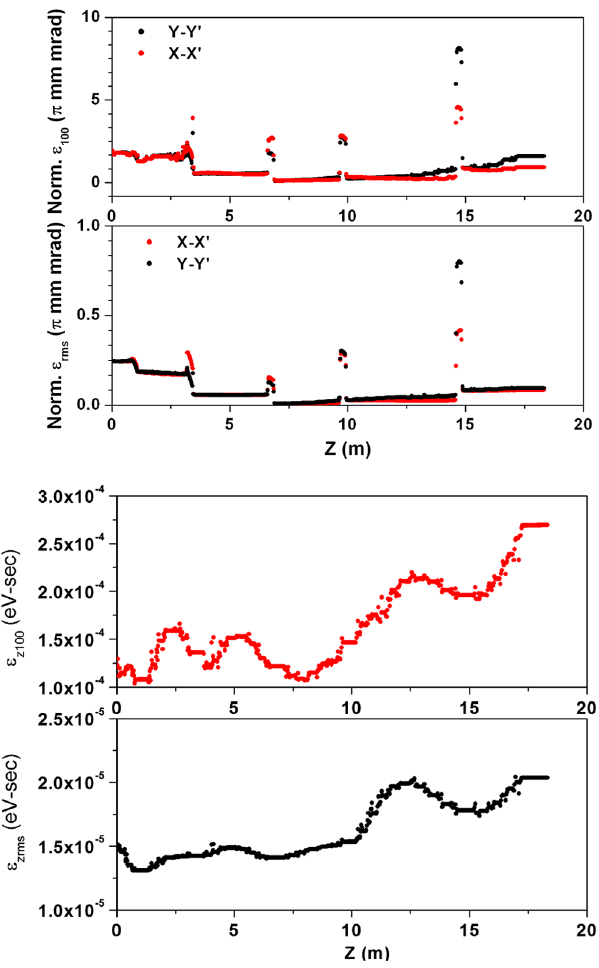
FIG. 13. Normalized longitudinal and transverse emittance value along the length.